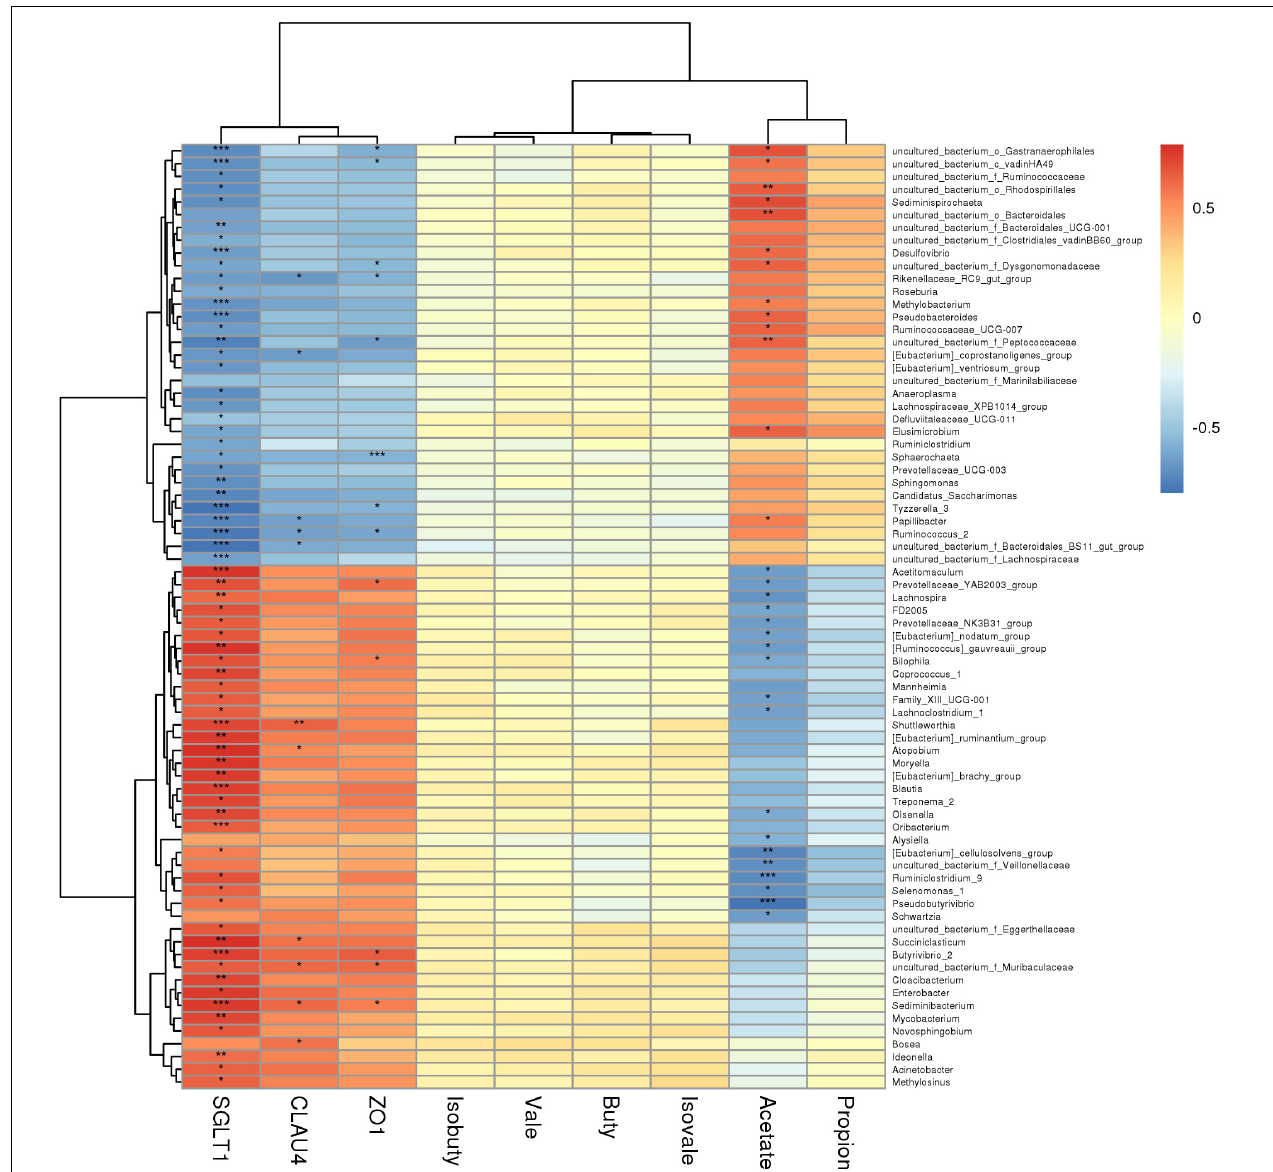
FIGURE 6 | Correlation heat map. * P < 0.05, ** P < 0.01, *** P <